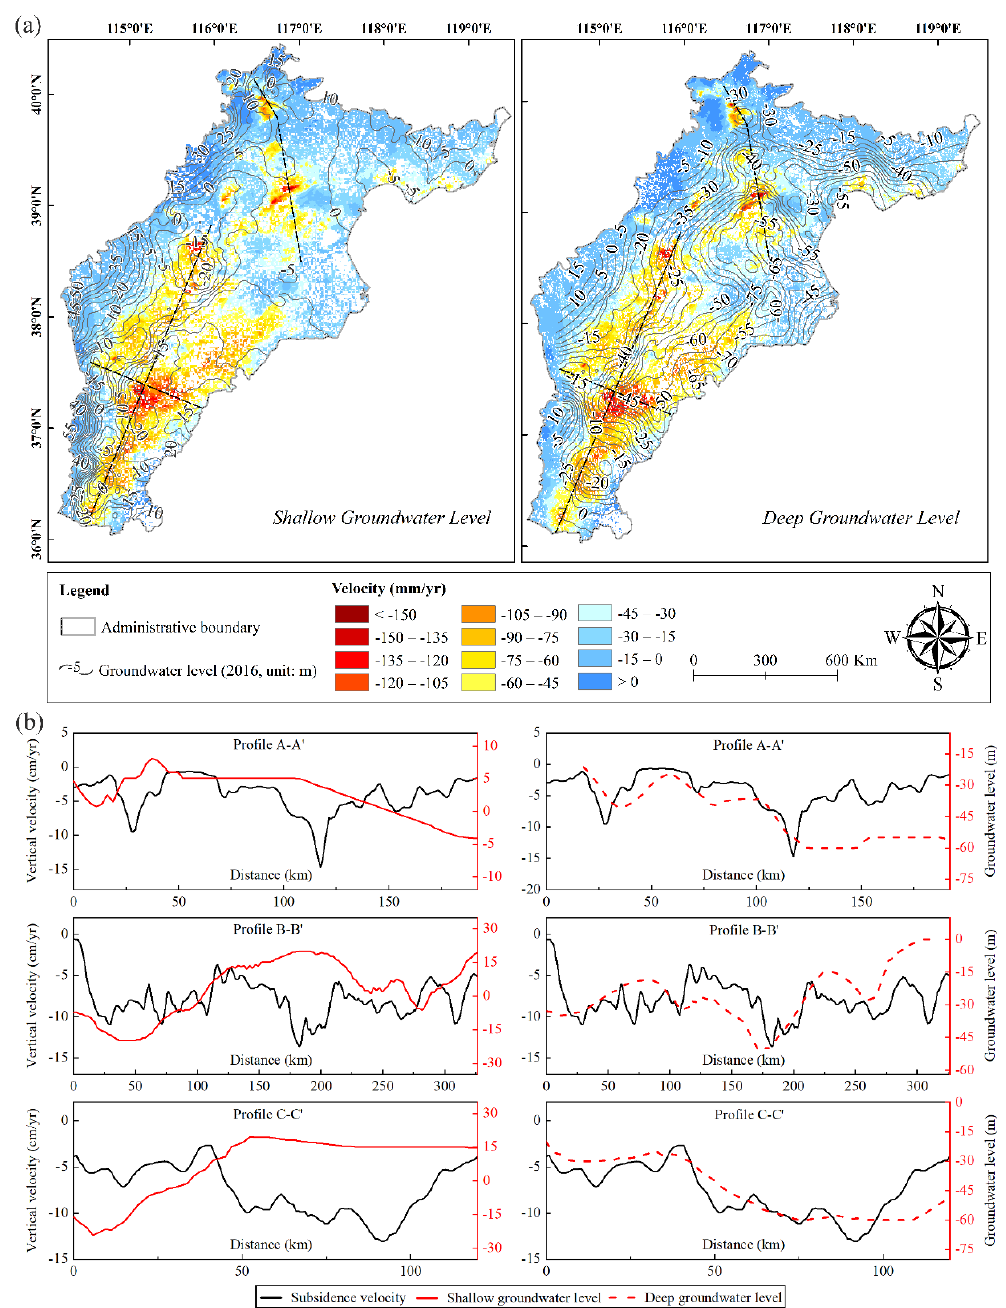
Figure 9. Relationships between land subsidence and hydraulic head levels: ( a ) overlap between hydraulic head levels and InSAR-measured subsidence and ( b ) the profiles A-A’, B-B’, and C-C’ drawn in the upper panel.